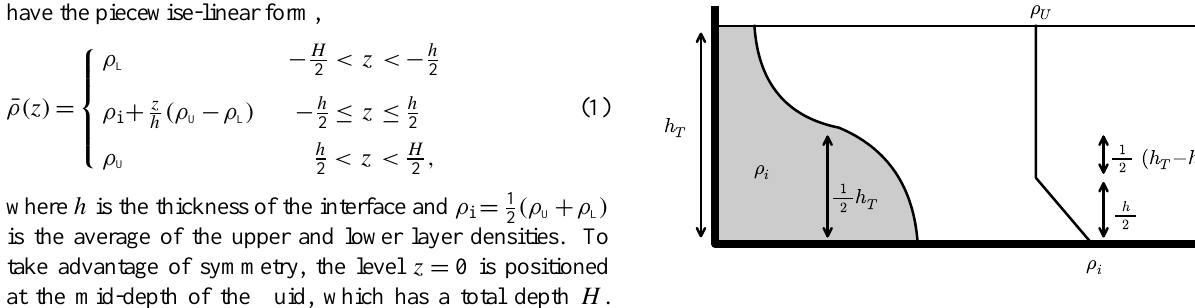
Fig. 1. The domain and the density profile used to derive a theory for the speed of intrusions as a function of interface thickness.